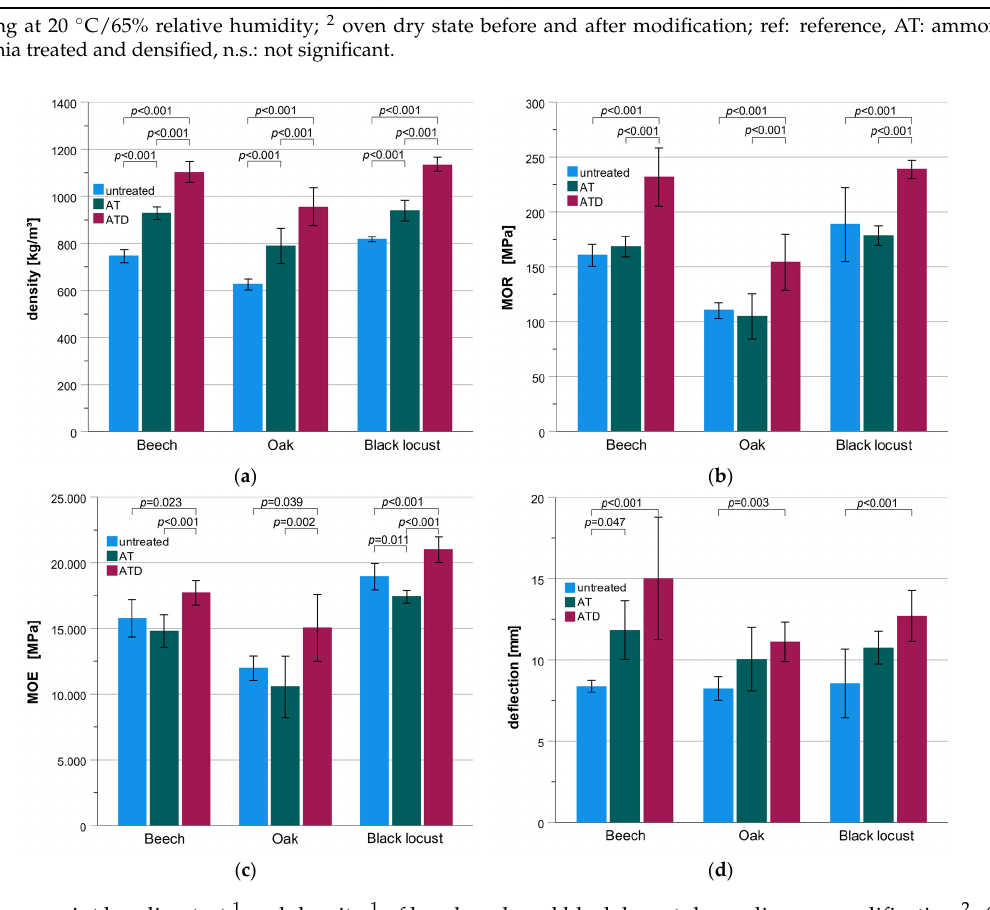
Figure 1. Three-point bending test 1 and density 1 of beech, oak and black locust depending on modification 2 : ( a ) density, ( b ) modulus of rupture, ( c ) modulus of elasticity and ( d ) maximum deflection during bending test. 1 conditioning at 20 °C/65% relative humidity. 2 untreated, AT (ammonia treated) and ATD (ammonia treated and densified)